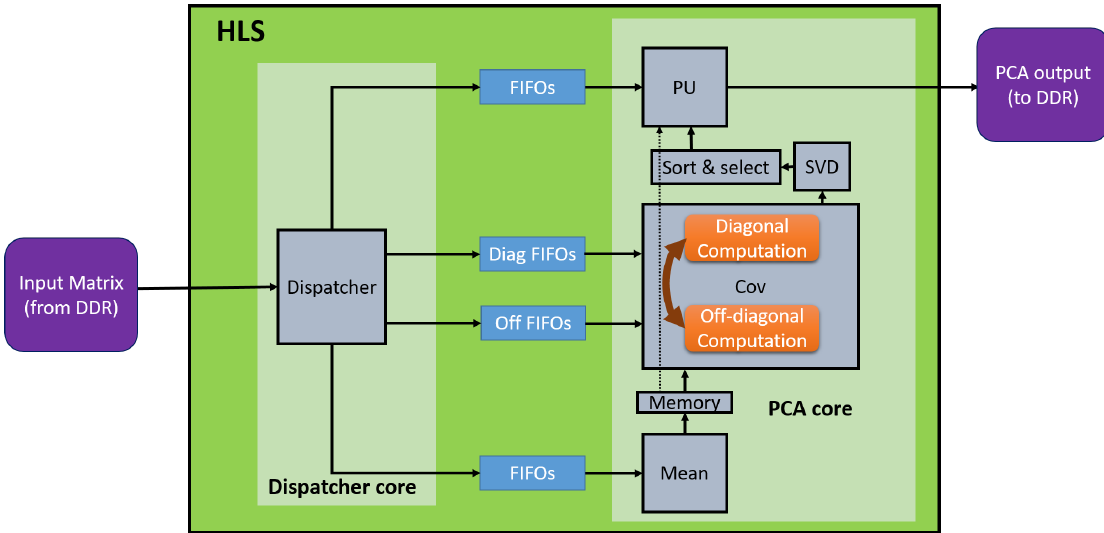
Figure 1. Architecture of the proposed hardware accelerator for Principal Component Analysis (PCA) in Field-Programmable Gate Arrays